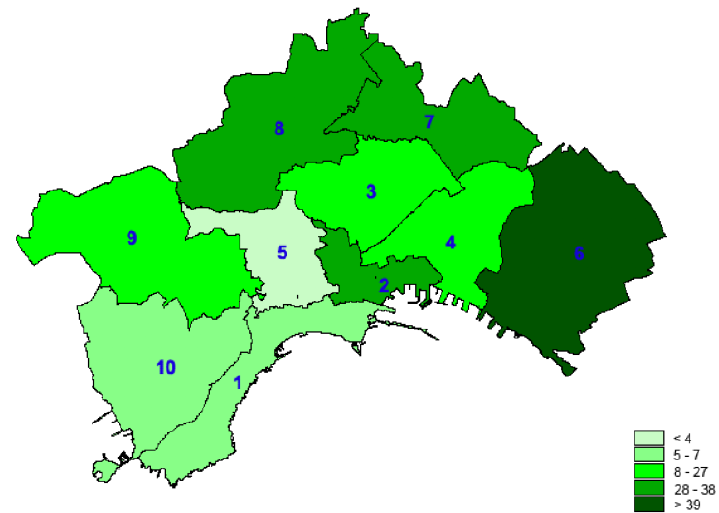
Figure 1. Number of babies born from mothers younger than 20 years old in each district of Napoli in 2008. Numbers on the figure are related to the numerical denominations of districts, whereas different colours refer to the different numbers of children born [24]. Table 1. The unemployment rate in VI District and Napoli *.